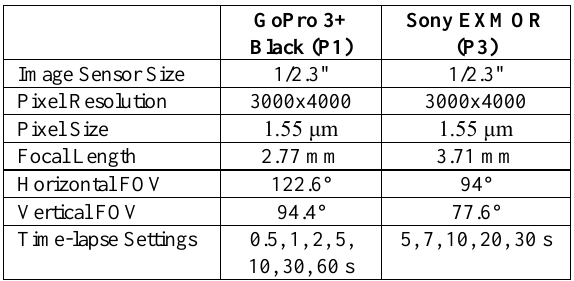
Table 2. Main characteristics of the cameras used during the